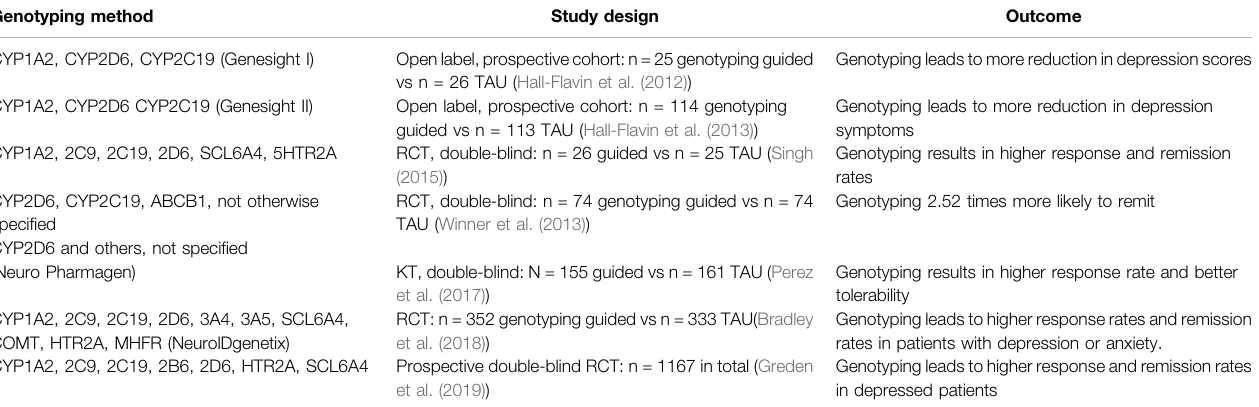
TABLE 2 | Prospective RCTs comparing PG guided vs non-guided pharmacotherapy, treatment as uual (TAU). Genotyping